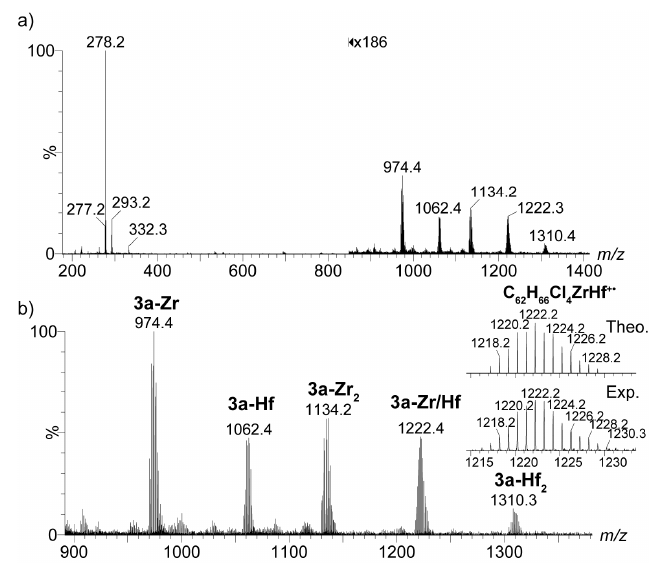
Figure 3. ( a ) The APPI(+) mass spectrum of the crude reaction mixture resulting from metallation of the proligand 3a by a 1:1 mixture of ZrCl 4 and HfCl 4 ; ( b ) The enlargement of the m / z 900–1350 area. The zoomed areas showcase the theoretical and experimental isotopic clusters of the dinuclear bis(dichloro ansa -metallocene) complexes 3a-Zr-Hf . For each isotopic distribution, only the most intense isotope peak is labelled.